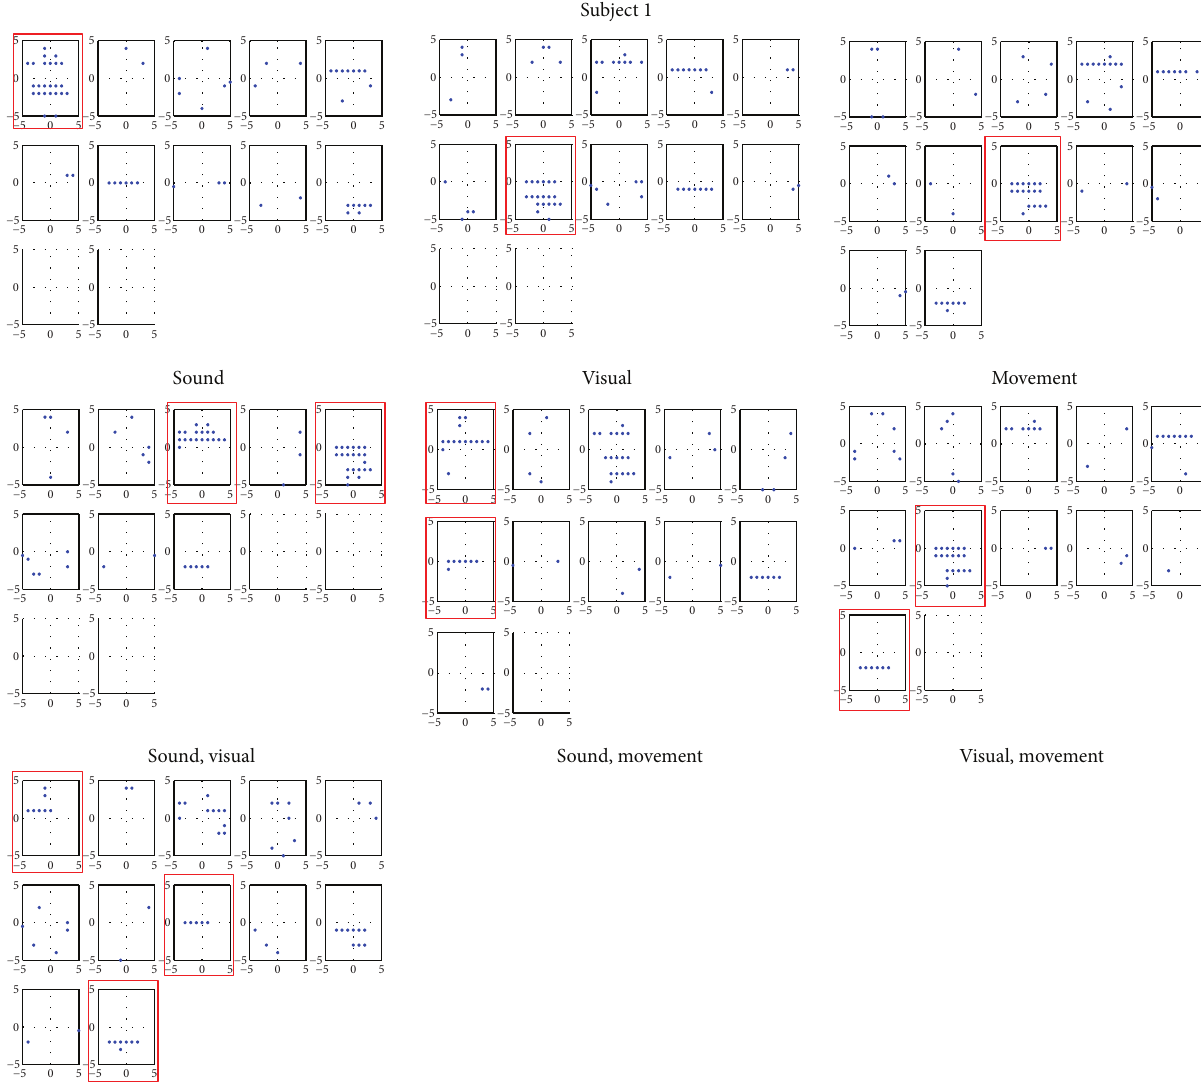
Figure 3: Results of grouping for Subject